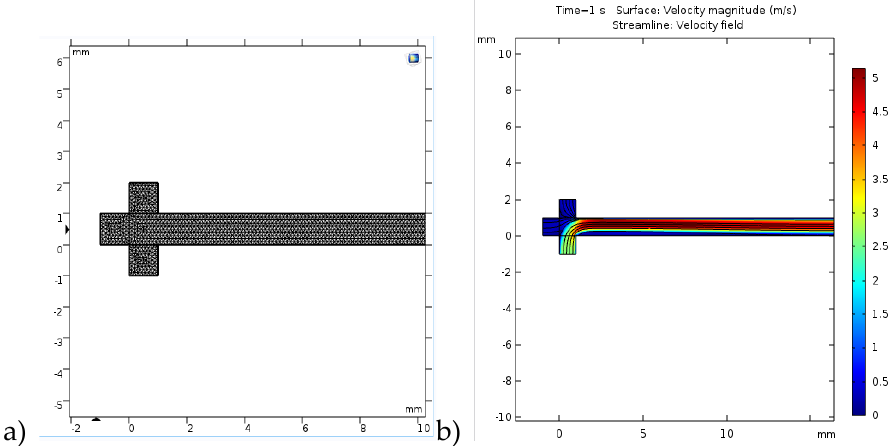
Figure 7. Computational fluid dynamics (CFD) simulation of velocity profile in microsystem ( a ) grid used for the simulation, and ( b ) velocity profile.